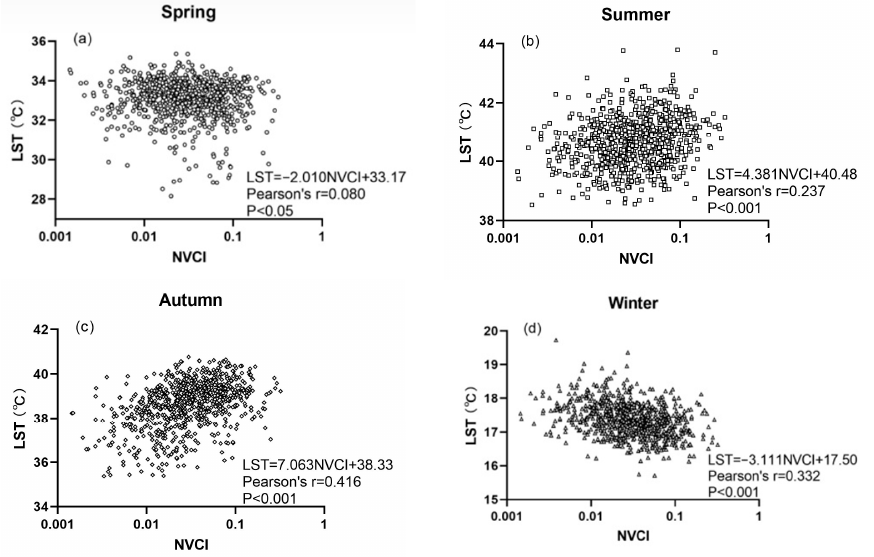
Figure 12. Relationships between NVCI and LST in ( a ) spring; ( b ) summer; ( c ) autumn; ( d ) winter. Table 8. Relationships between NVCI and LST across four seasons.